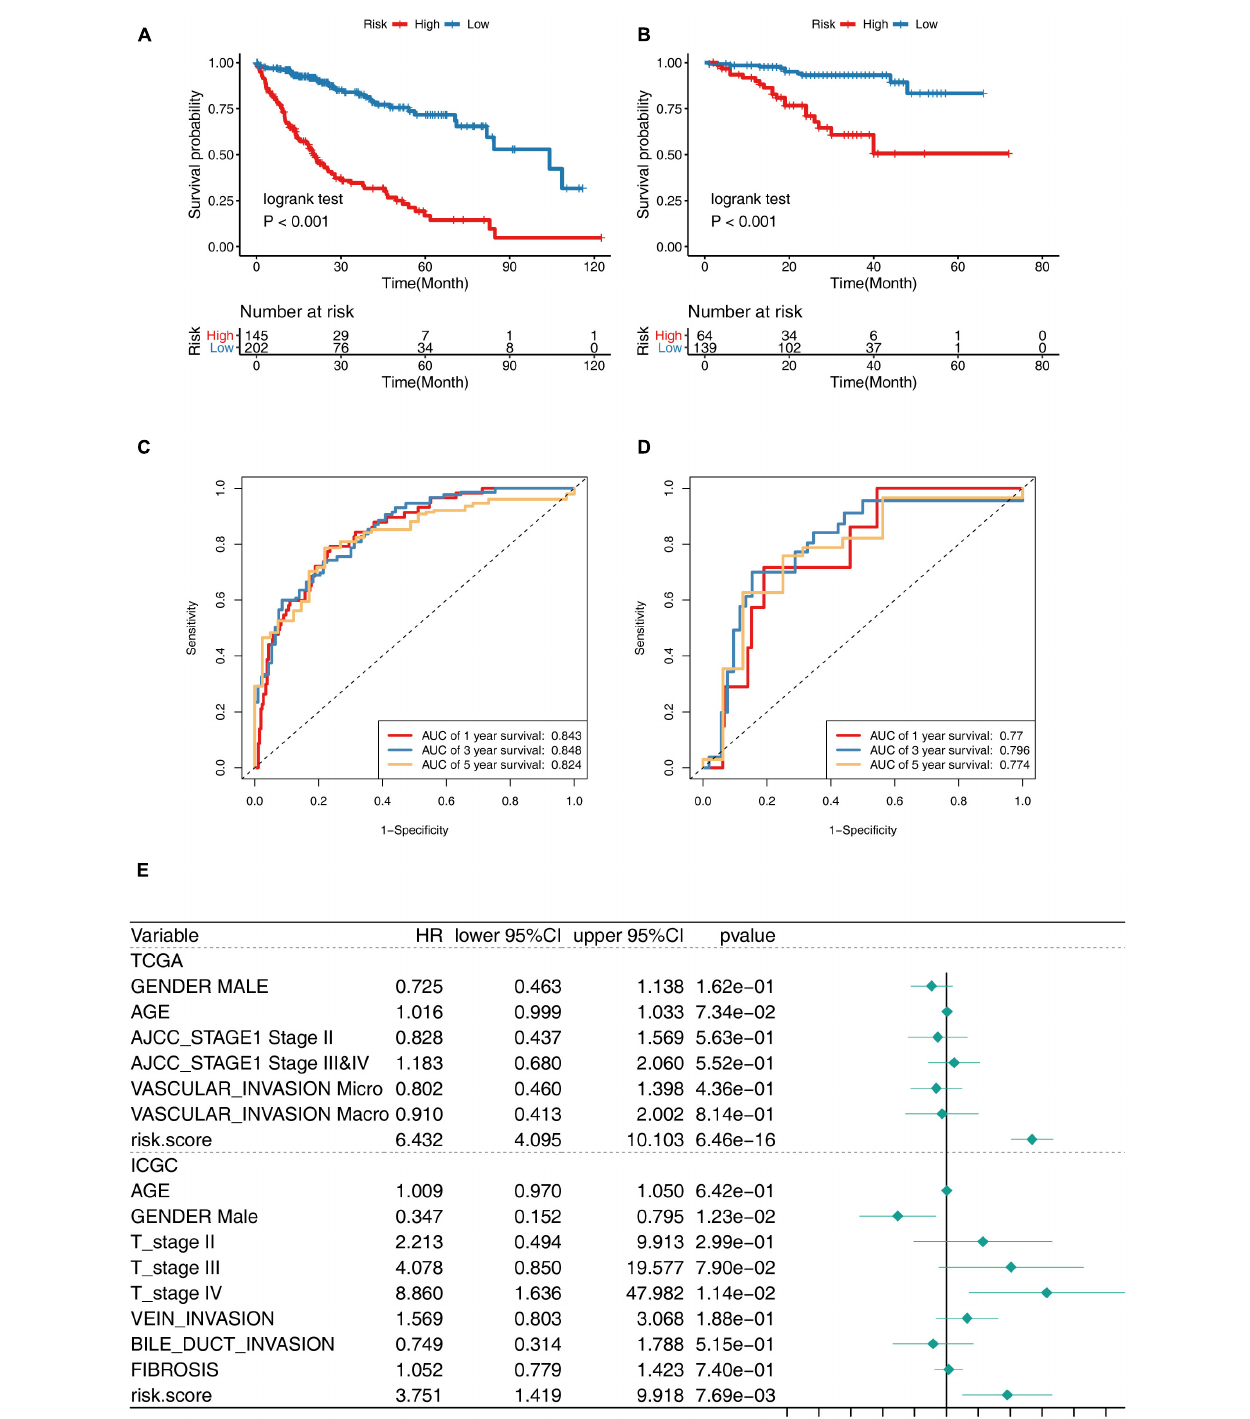
FIGURE 5 | Prognostic performance of 30-gene signature in TCGA Training Cohort and ICGC Validation Cohort. (A,B) K–M survival curve for risk score in TCGA training cohort (A) and ICGC validation cohort (B) . (C,D) Receiver operating characteristic (ROC) curve of the 30-gene prognostic model in TCGA cohort (C) and ICGC cohort (D) . (E) Multivariate Cox regression analysis of clinical parameters and prognostic model for OS.